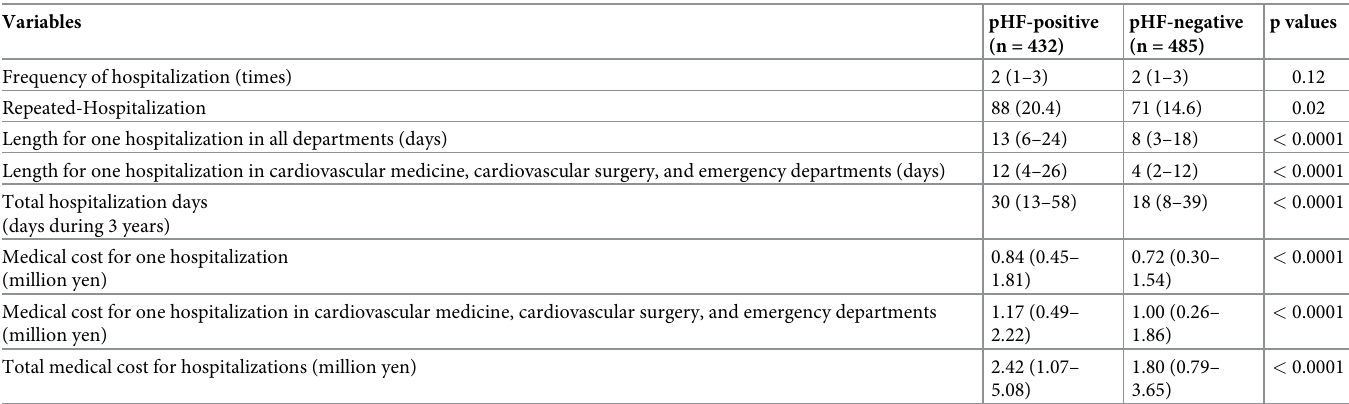
Table 2. Hospitalization data of the past 3-year period.